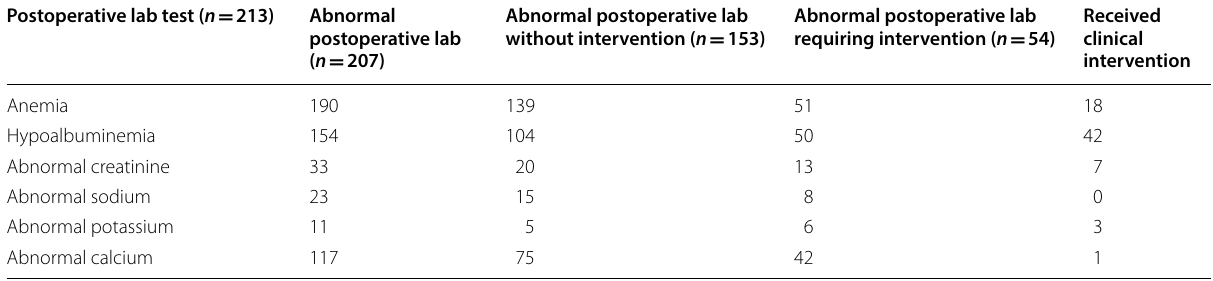
Table 4 Abnormal postoperative laboratory tests and intervention directly related to abnormal laboratory